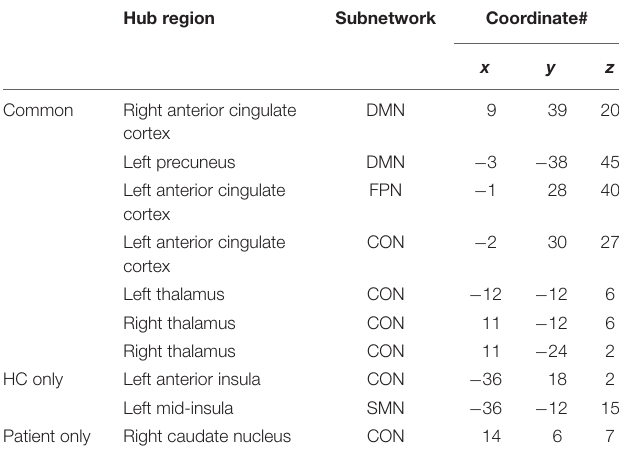
TABLE 4 | Hub regions in patients with PD and